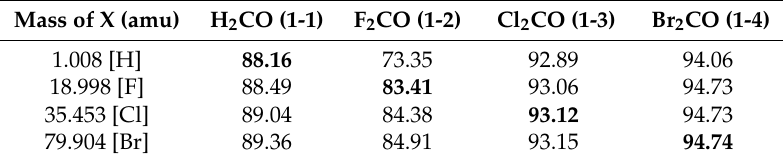
Table 2. Comparison of the performance scores of molecules X 2 CO, 1-1 – 1-4 using the atomic masses X = H, F, Cl, and Br. Each column represents the same electronic structure with different masses and a row represents same atomic mass with different electronic